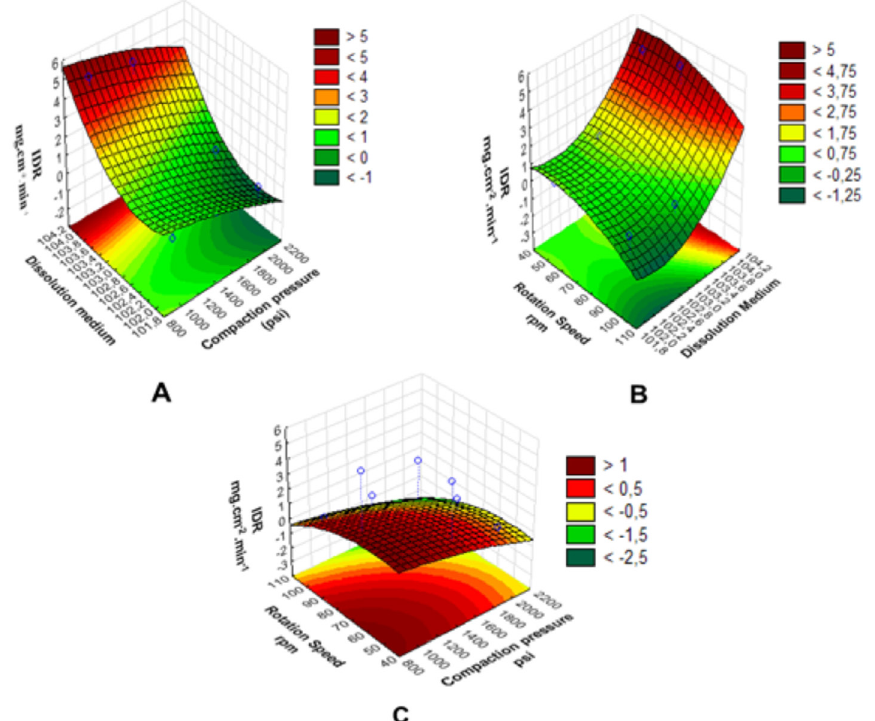
FIGURE 6 - Surface-response graphs for the IDR of amlodipine besylate compared to the studied factors (A) dissolution medium x compaction pressure, (B) dissolution medium x rotation speed, and (C) compaction pressure x rotation